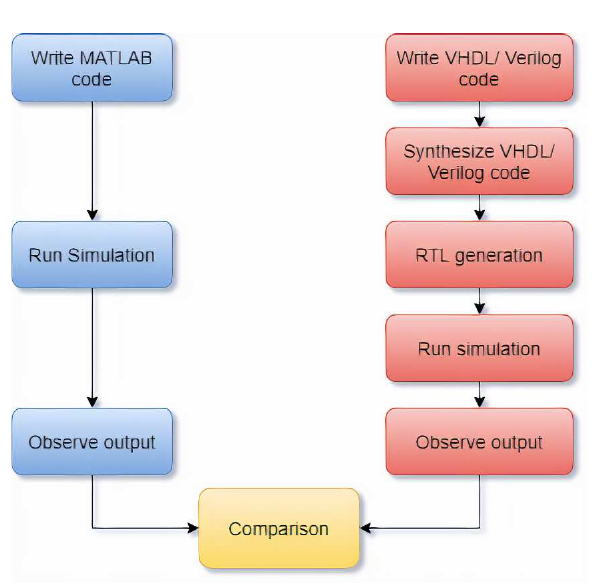
Figure 2. Flow chart.